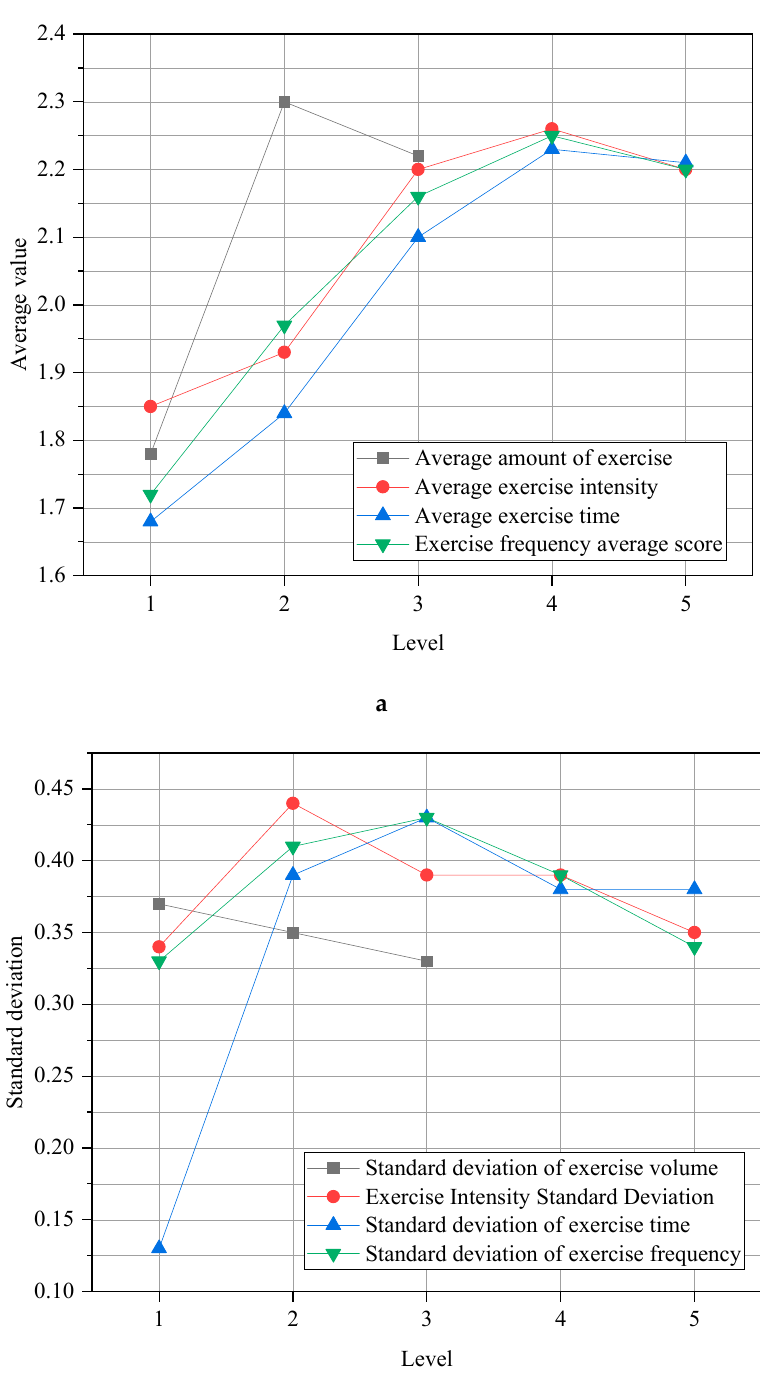
Figure 6. Test results of the difference between positive psychological emotions and physical exercise: ( a ) the mean value of positive emotion in physical exercise; ( b ) the standard deviation of positive emotion in physical exercise. Table 4. The significance test of positive emotions in physical exercise.